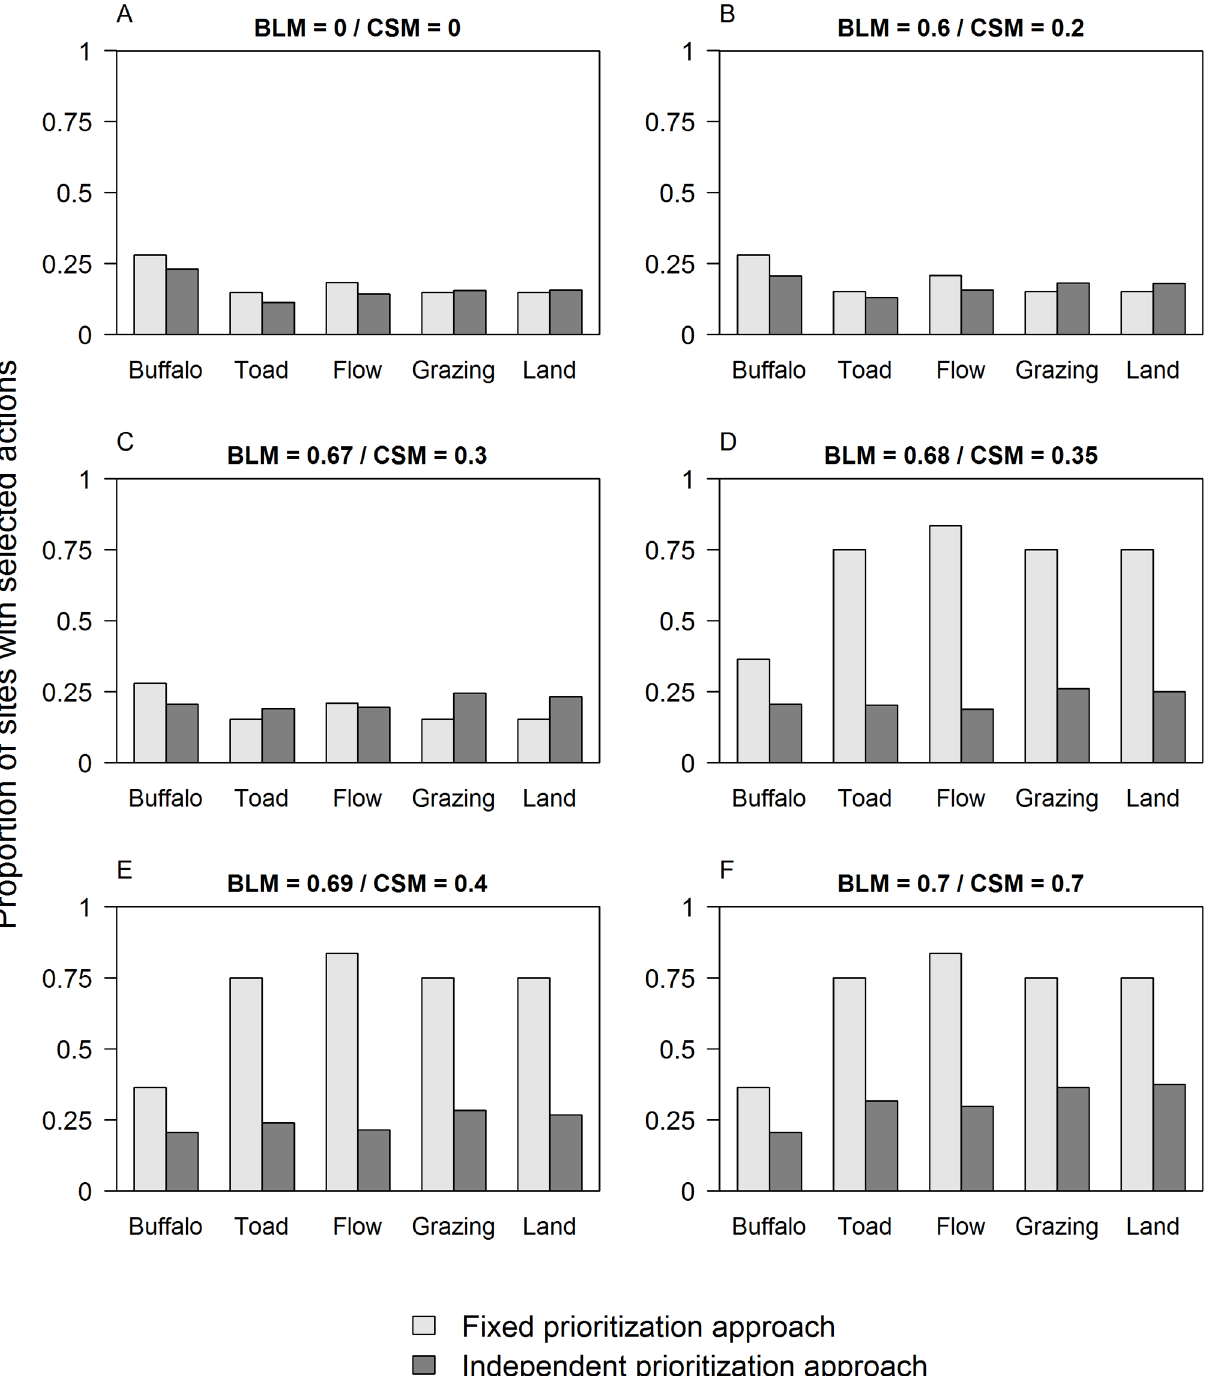
Fig 4. Proportion of sites where each action was selected for the fixed and the independent prioritization approach. The value on the y axis is calculated as number of sites where the action was selected out of the total number of sites where the action was available for selection. Results are shown for different values of BLM (Fixed Prioritization Approach) and CSM (Independent Prioritization Approach) (A — F).